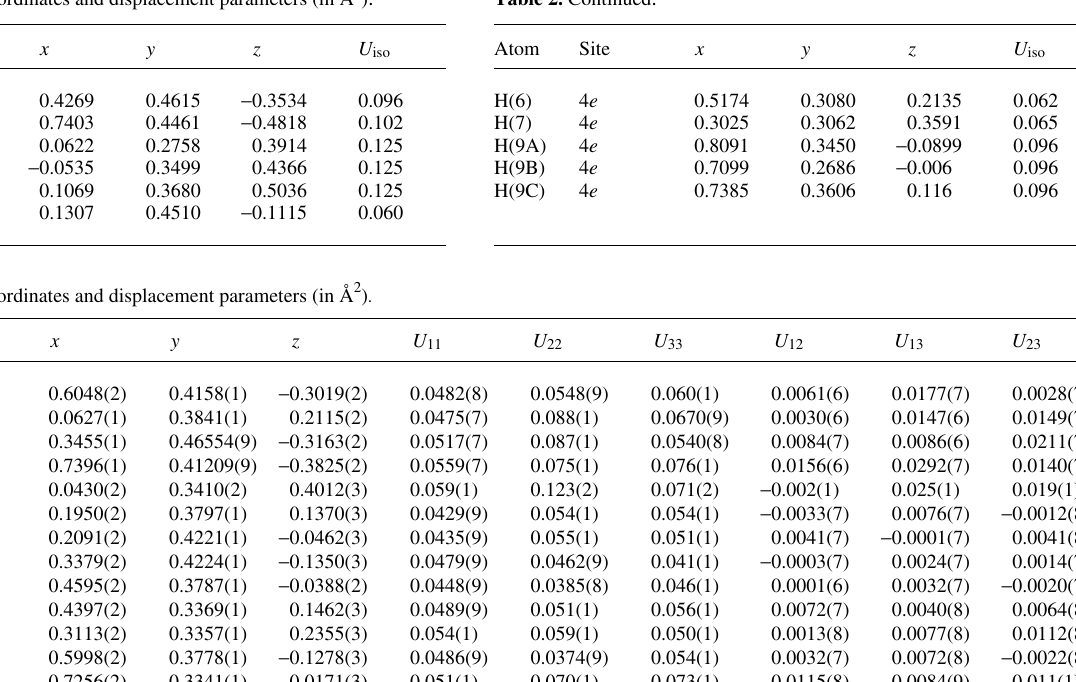
Table 2. Atomic coordinates and displacement parameters (in Å 2 )